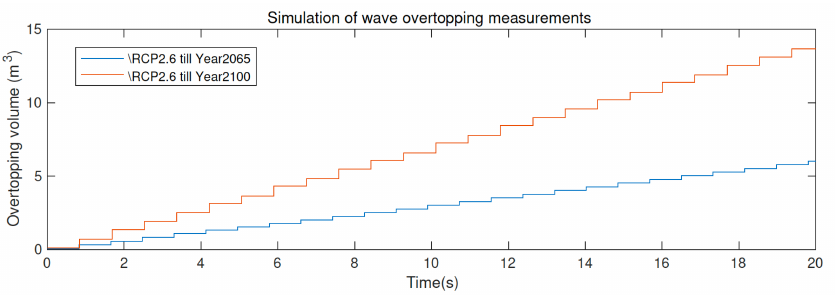
Figure 11. Overtopping volume over the double-dike defence structure under the RCP2.6